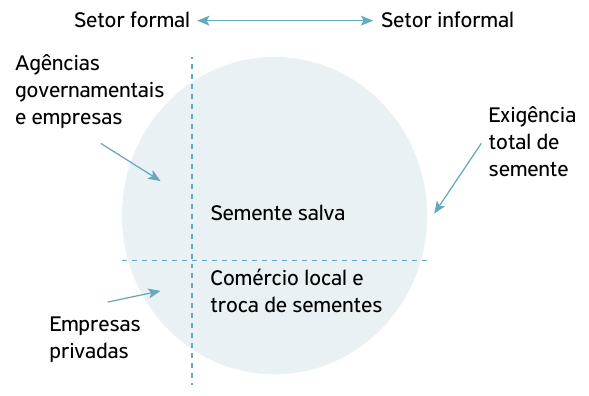
Figura 2. Divisões no sistema